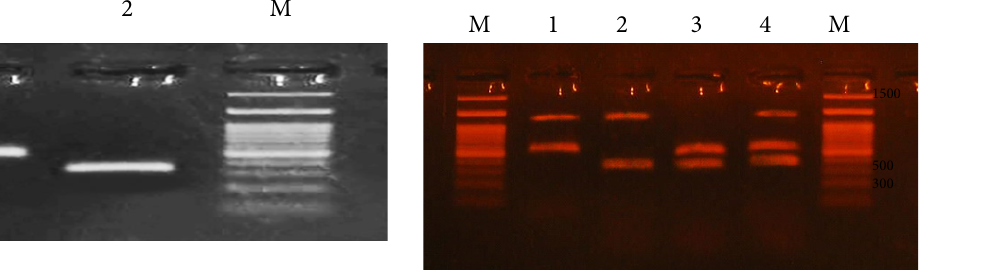
Fig. 4. Multiplex PCR for virulence genes in E. coli isolates. Lane (1): cnf-1 (band at 498 bp), Lane (2): papC (band at 328 bp), Lane (M): 100 bp DNA ladder